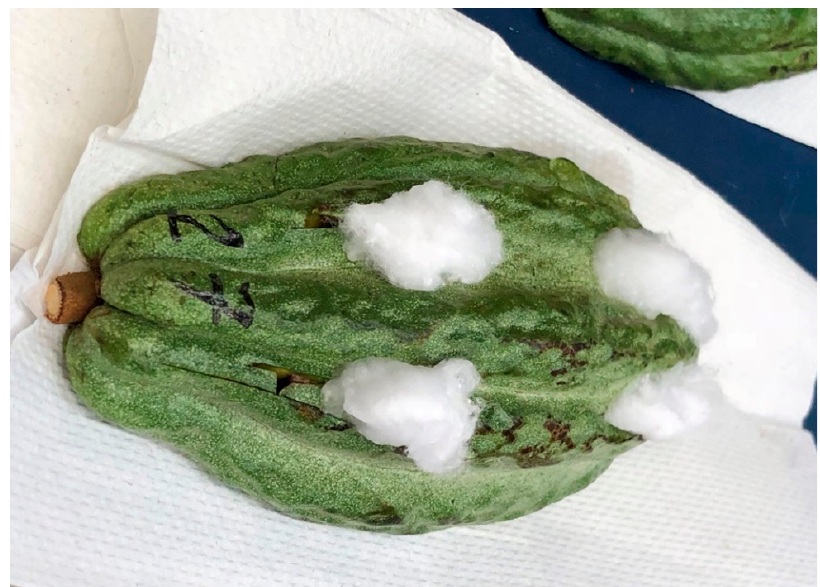
Figure 2. Phytophthora palmivora was isolated from diseased pod and stem samples by surface- sterilizing and inserting tissue into a healthy cacao pod.